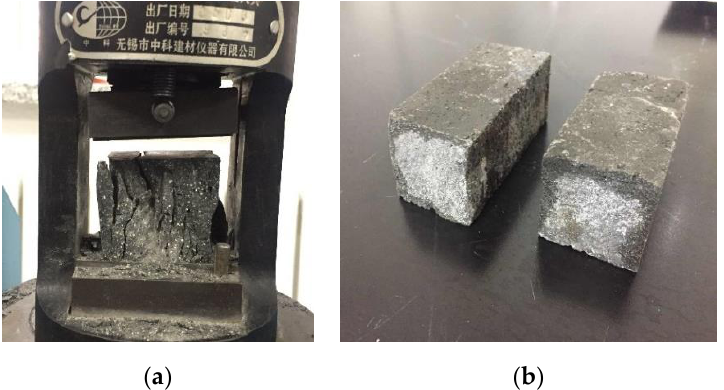
Figure 7. Failure morphology of BFRPC: ( a ) compressive mode; and ( b ) flexural mode.